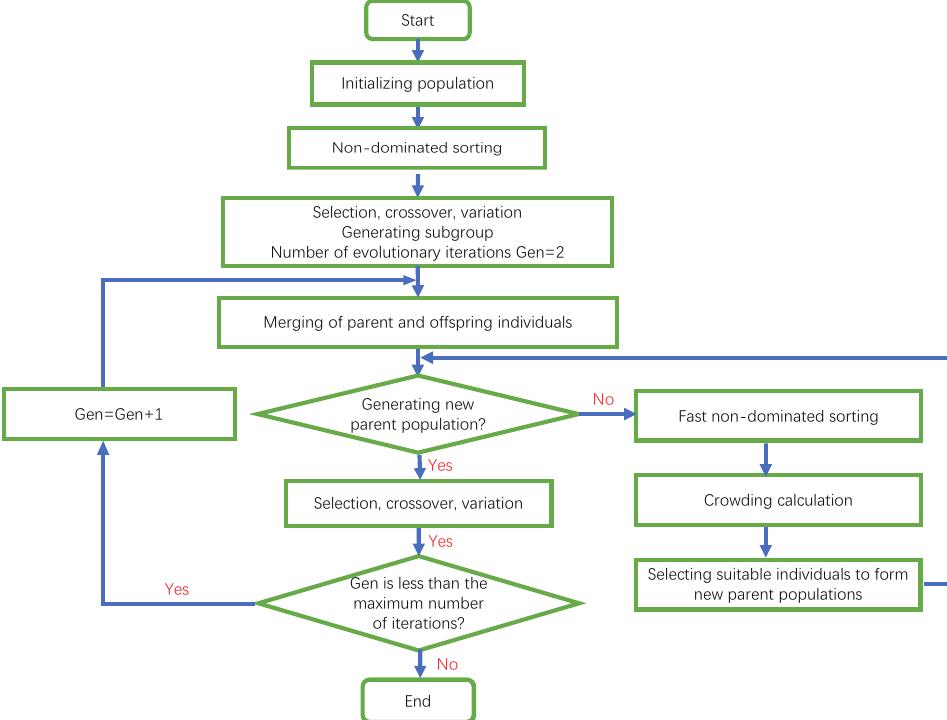
Figure 6. The fundamental concept of the NSGA-II algorithm. A random initial population, using selection, crossover, and variation to produce a first generation of offspring populations. Parent and offspring populations are mixed and individuals are selected for new parent populations based on their non-dominance relationships and crowding levels, which in turn produce new offspring populations. This figure is adopted from